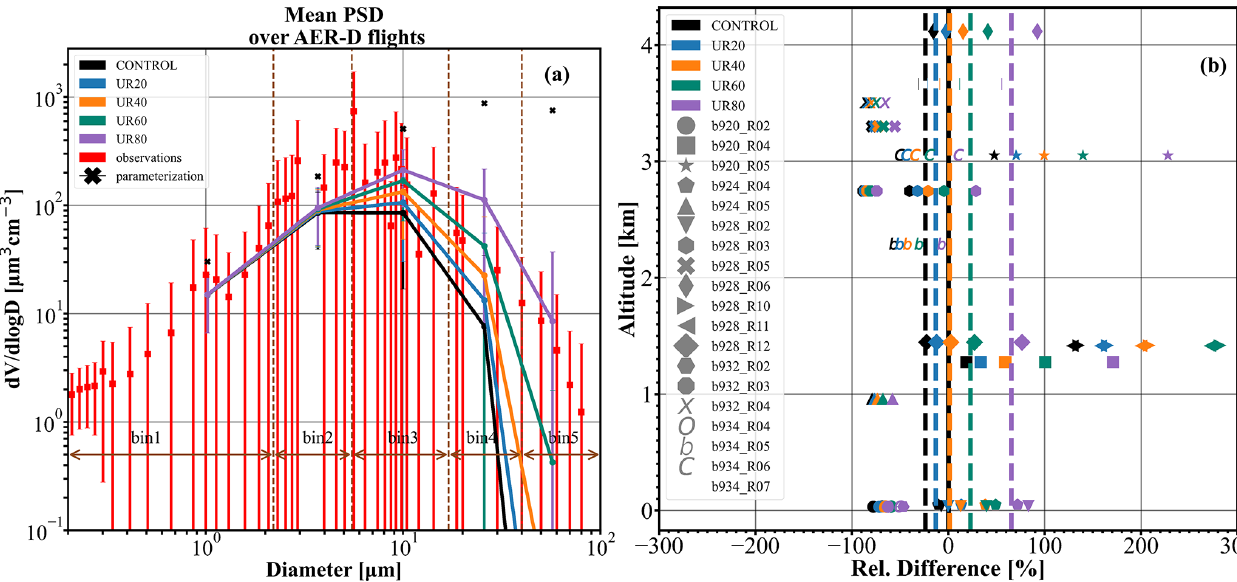
Figure 8. (a) Mean PSD of the AER-D/ICE-D campaign. The observations are shown with red squares, whereas the simulations are shown with solid lines for the CONTROL run (black), UR20 (blue), UR40 (orange), UR60 (green), and UR80 (purple). (b) The relative difference between the observations and the model simulations of the total volume of dust particles, at different altitudes. The observations from different flight segments (i.e., b920 R02, b920 R04, b920 R05, b924 R04, b924 R05, b928 R03, b928 R05, b928 R06, b932 R02, b932 R03, b932 R04, b934 R04, b934 R05, b934 R06, and b934 R07) are denoted with different markers. The average relative difference of the observations and the simulations are denoted with dashed lines for the CONTROL run (black), UR20 (blue), UR40 (orange), UR60 (green), and UR80